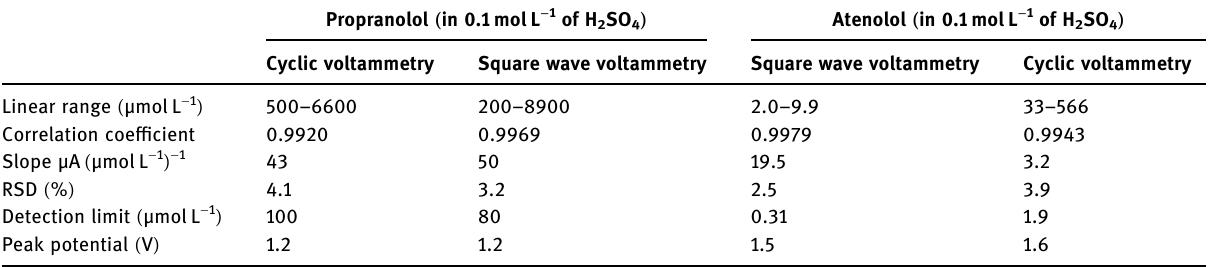
Table 1: Quantitative analytical results of the investigated β blockers by SWV and CV